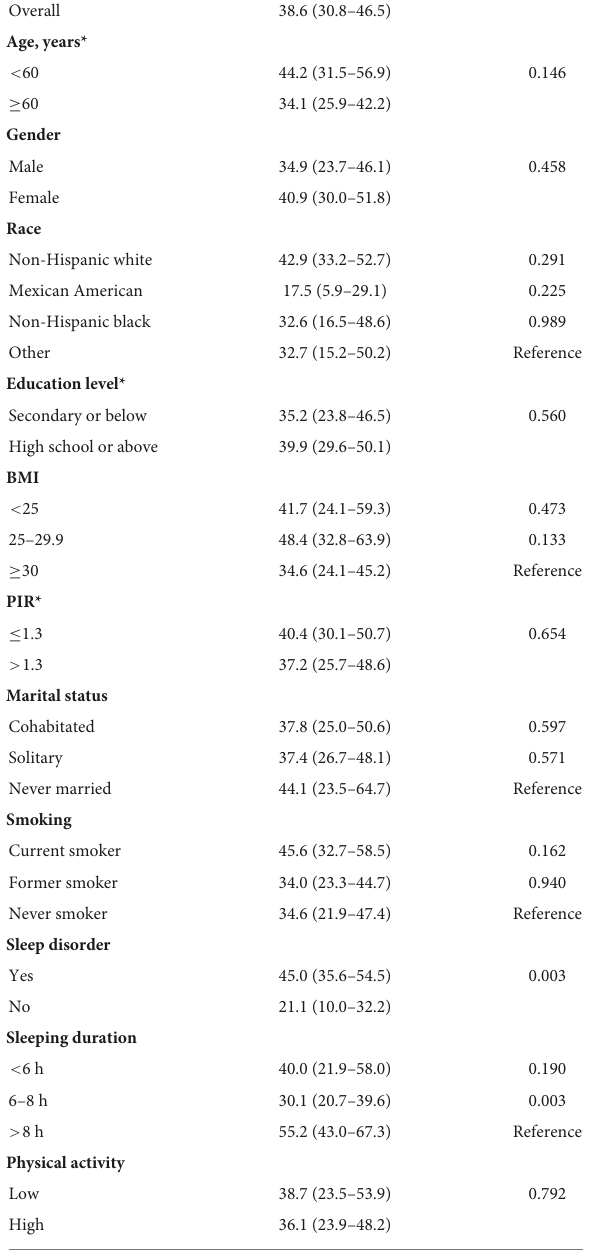
TABLE 4 Antidepressant use among depressed cardiovascular patients in the United States, 2013–March 2020.